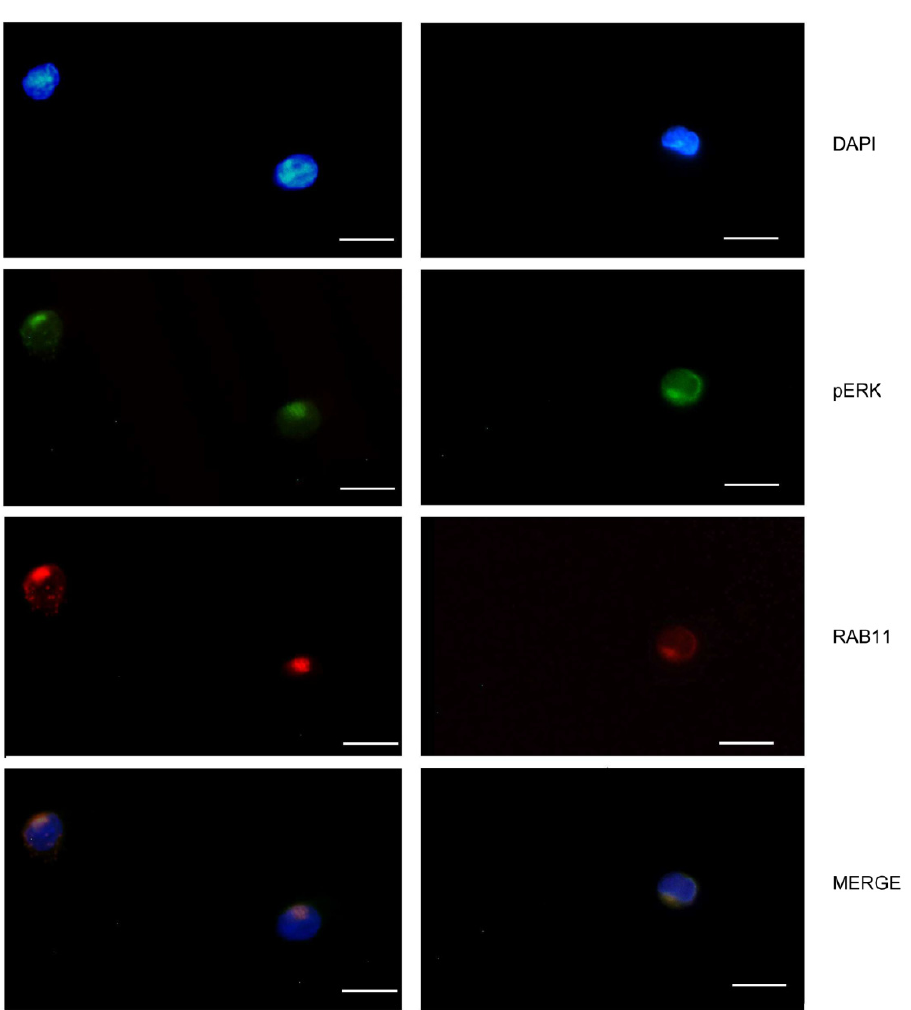
Figure 3. pERK localized in the same compartment with RAB11. Fluorescence images show the same cellular compartment localization of pERK with RAB11 after the OSM treatments on LY4759 cells. Two examples are reported in the two columns. The perinuclear structures in which pERK and RAB11 cluster in ERC formations are visible. The scale bar is 20 µm.